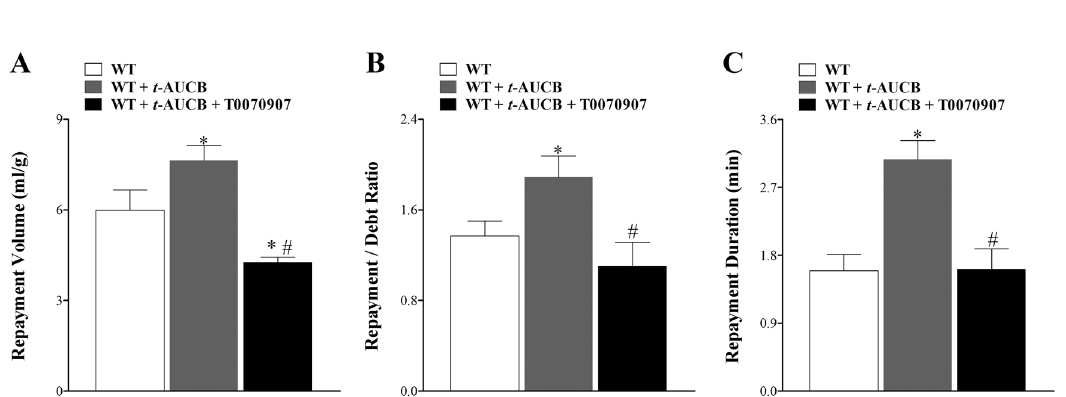
Fig 10. Effect of T0070907, PPAR γ -antagonist (10 μ M) on t -AUCB-enhanced CRH in WT in wild type (WT) mice. Each WT isolated mouse heart was used as its own control. Inhibition of sEH by t -AUCB enhanced CRH in WT mice. Infusion of t -AUCB (10 μ M) increased repayment volume (RV) (p < 0.05, A), repayment/debt ratio (p < 0.05, B), and repayment duration (RD) in WT mice (p < 0.05, C). The t -AUCB-enhanced CRH was attenuated by T0070907. T0070907 decreased RV (A), R/D ratio (B), and RD (C) in t-AUCB-treated-WT mice (p < 0.05). * p < 0.05 versus WT. n = 6.